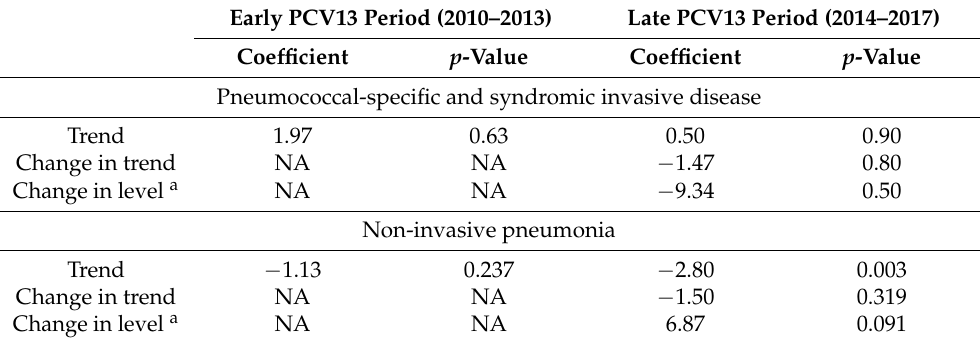
Table 3. ITS analysis of annual IRs of invasive pneumococcal disease and non-invasive pneumonia.